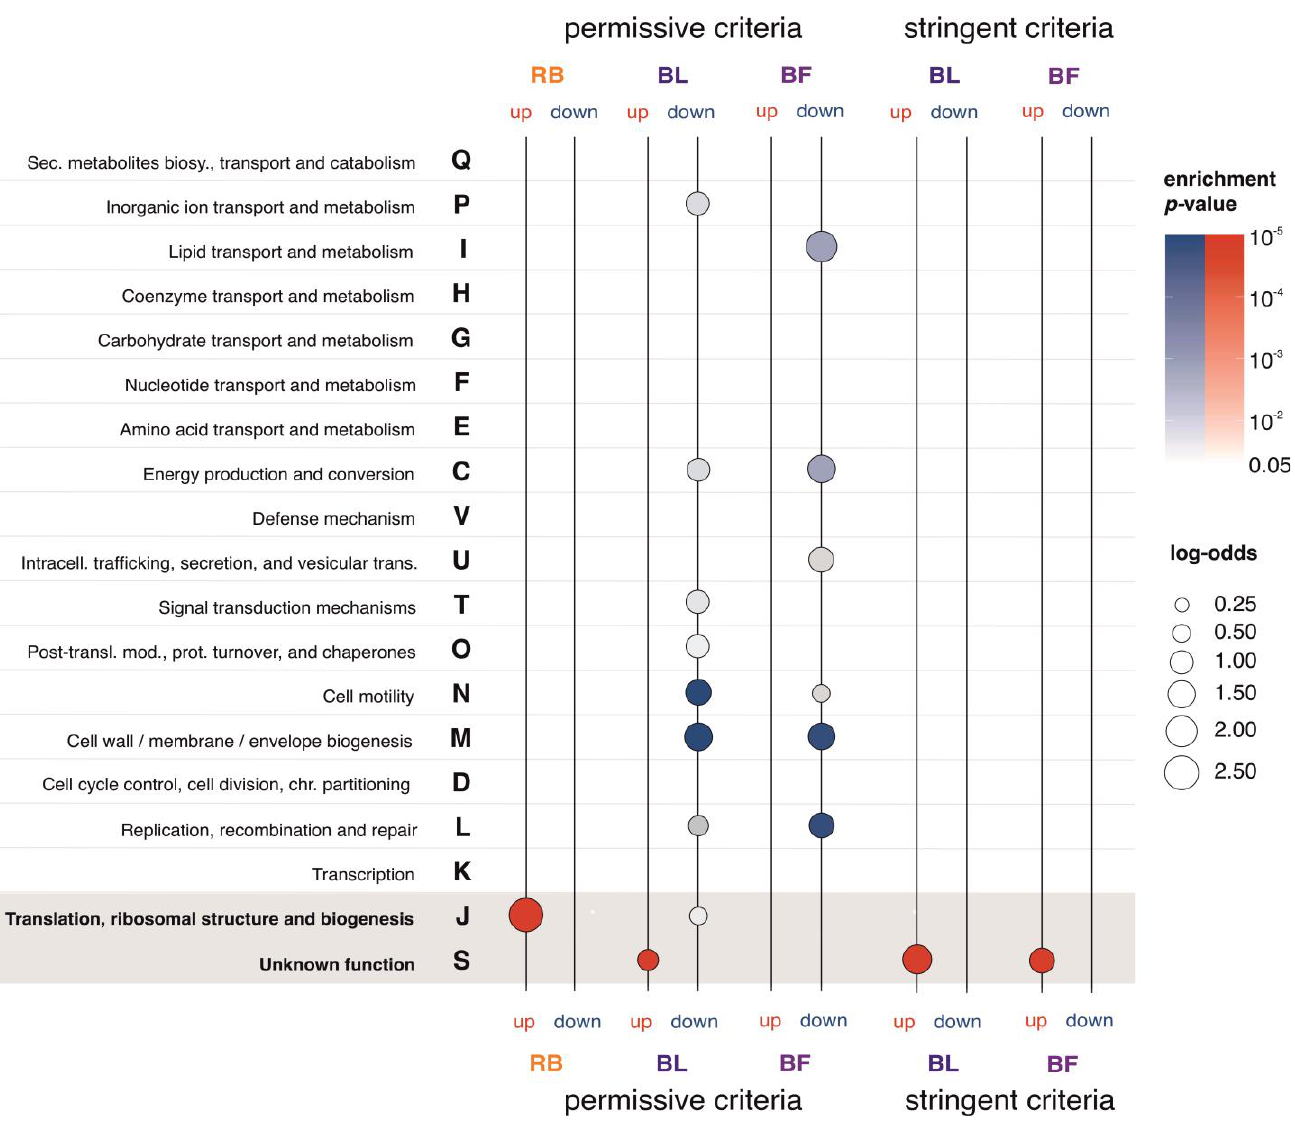
Figure 3. The functional enrichment analysis of differentially expressed genes in B. burgdorferi morphotype-dominated cultures. We showed the enrichment profiles of COG functional annotations for upregulated (up, red color) and downregulated (down, blue color) genes that we detected in the round body (RB), bleb (BL), and biofilm (BF) dominated cultures. We tested the significance of enrichment by two-tailed hypergeometric test corrected for multiple comparisons at 0.05 level (Table S5). Differentially expressed genes were determined in reference to spirochetes using DeSeq2 pairwise comparisons. Under permissive criteria, we considered a gene to be differentially expressed if the shift in its expression was statistically significant ( p < 0.05). Under stringent criteria, we additionally required that the magnitude of change was at least twofold. Under the stringent criteria, there were no differentially expressed genes in round bodies, thus the enrichment analysis was not performed. The magnitude of functional enrichments is depicted by log-odds (circles of different sizes) and their significance is shown in color shades ( p -values). The gray shaded area marks functions with significant enrichments in upregulated genes across morphotypes.